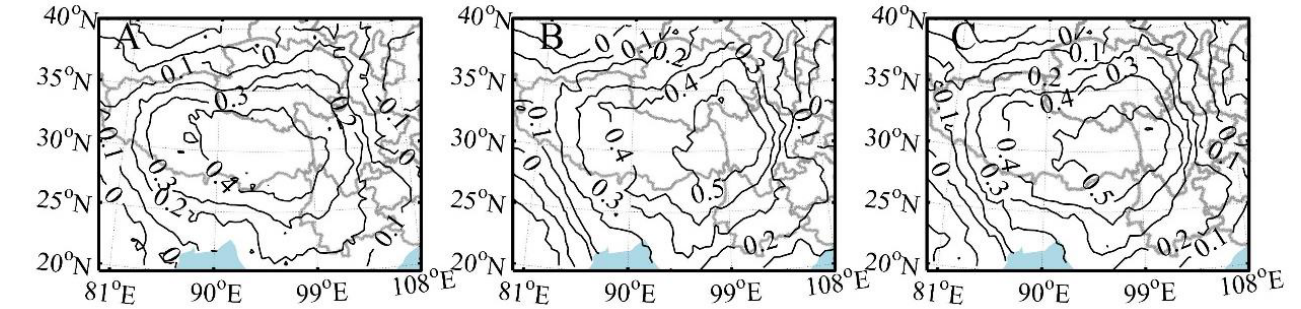
Figure 7. Spatial correlation of MXD (RES) and CRU TS 4.04 mean temperature of August – October (1951 – 2019) for ( A ) L. speciosa , ( B ) A. delavayi , and ( C ) composite chronology.